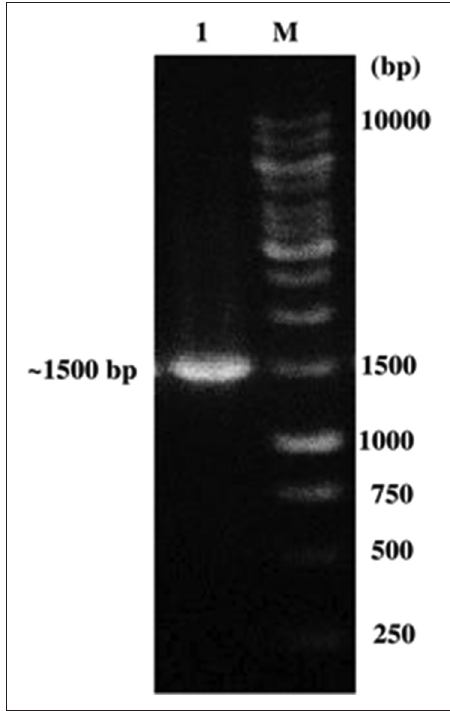
Figure-1: Polymerase chain reaction amplification product on Agarose gel (1%) (~1500 bp). Lane 1: Bacterial isolate 3A; lane 2: Marker 1 Kb. Table-1: Percent similarity the sequences of 16S rRNA bacterial isolate 3A to Staphylococcus species. References